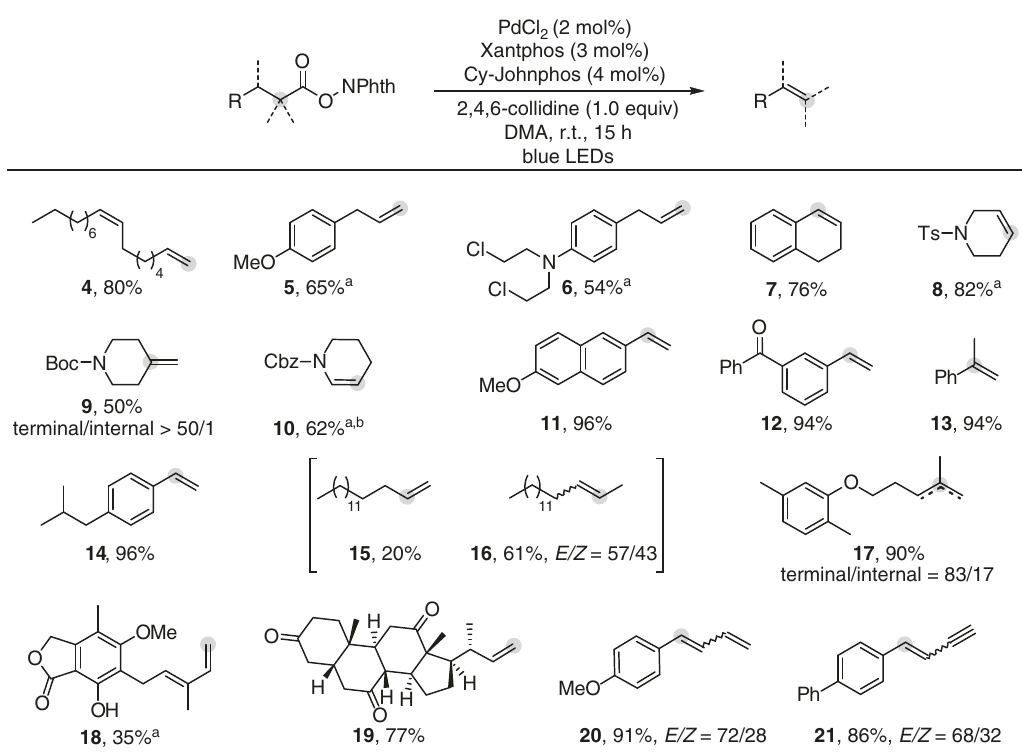
Fig. 2 Scope of the reaction with respect to aliphatic carboxylates. Reaction conditions: aliphatic carboxylates (0.2 mmol), PdCl 2 (2 mol%), Xantphos (3 mol%), Cy-JohnPhos (4 mol%), and 2,4,6-collidine (1.0 equiv) in DMA (2 mL), irradiated with 30 W blue LEDs for 15 h under Ar. Yields of isolated products, the ratio of isomers determined by 1 H NMR analysis. a PdCl 2 (5 mol%), Xantphos (6 mol%), and Cy-JohnPhos (10 mol%) were used. b Benzyl 5,6- dihydropyridine-1(2 H )-carboxylate was obtained in